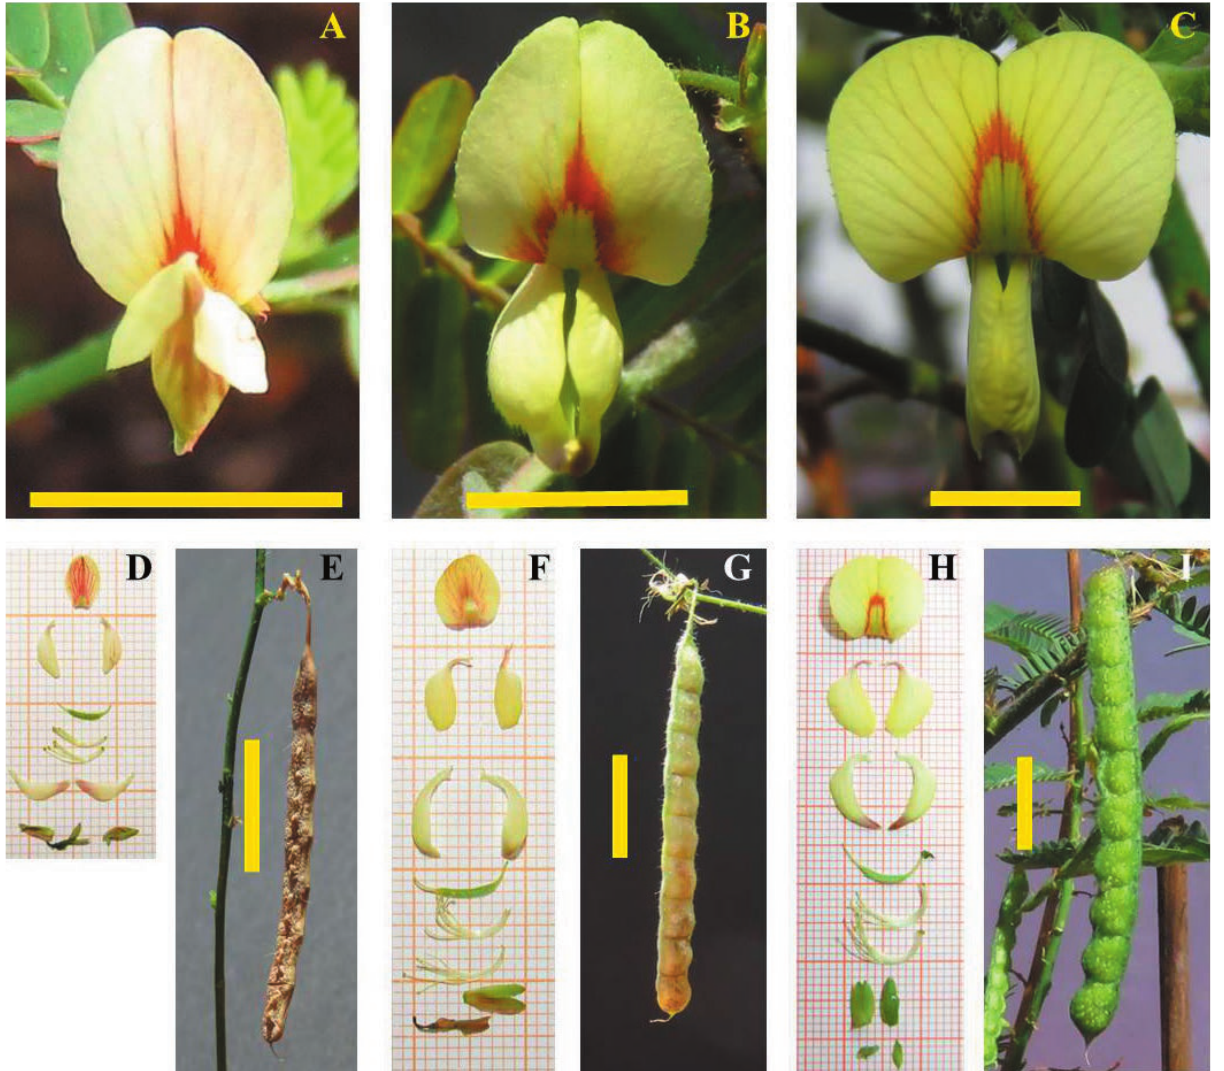
Figure 3. Floral morphotypes (above), dissected flowers and fruits (below) of the taxa under study. A , D and E , Aeschynomene evenia ; B , F and G , A. scabra ; C , H and I , hybrid of Aeschynomene . All three taxa exhibit typical pea or papilionoid flowers. These zygomorphic flowers comprise a standard (vexillum or banner) petal (adaxially placed), two lateral petals (wings) and two (usually partially fused and abaxially placed) keel petals, which conceal the androecium and gynoecium. The fruits have similar characteristics and are mainly differentiated by their size. Above scale bar = 0.5 cm, below = 1.0